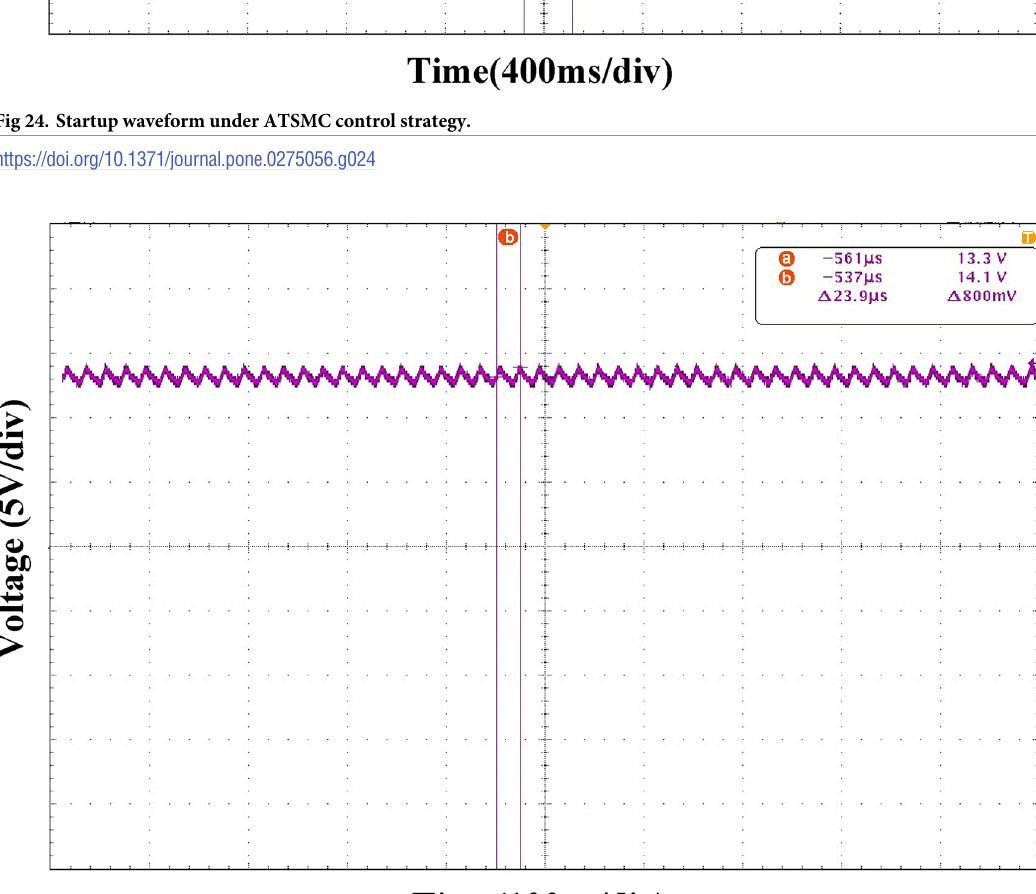
PLOS ONE | https://doi.org/10.1371/journal.pone.0275056 September 22,